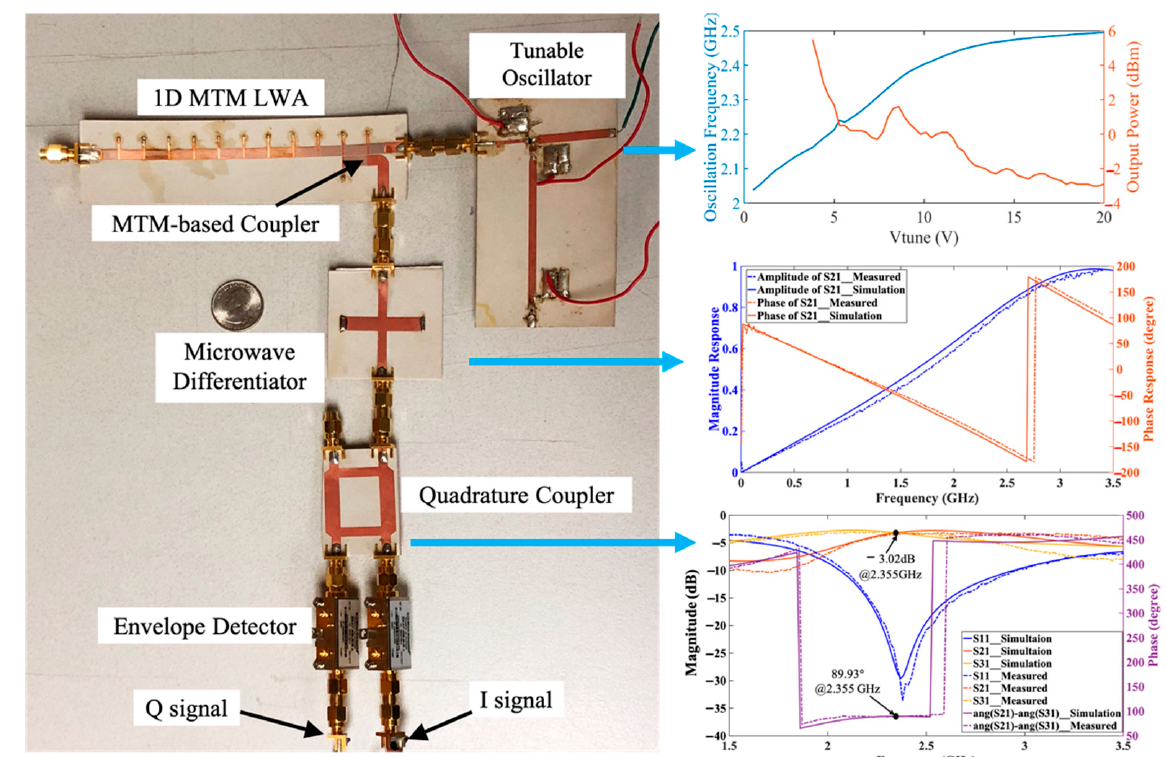
Figure 16. Prototype of the MTM LWA based on SIL radar sensor architecture at 2.4 GHz band.